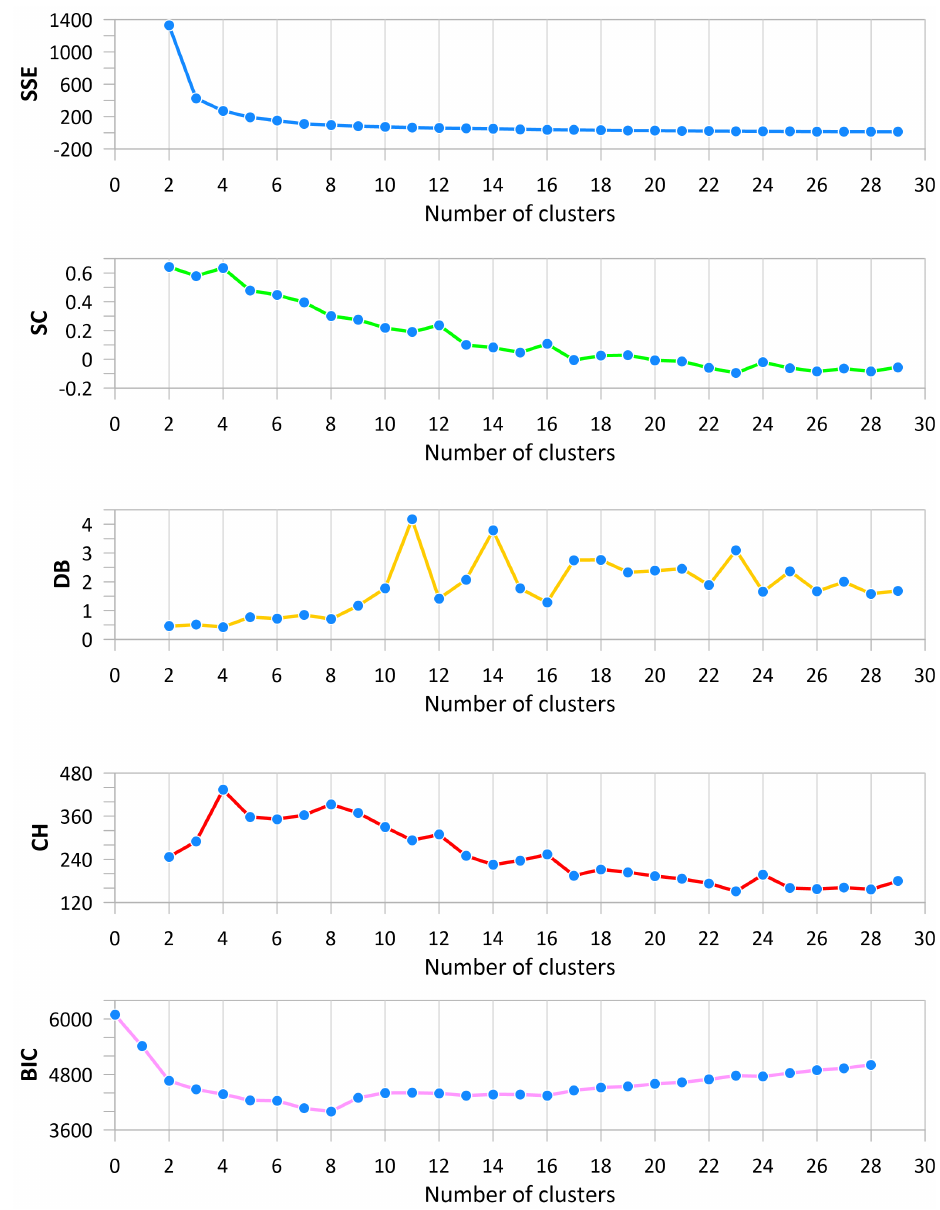
Figure 4. Metrics for cluster number validation for walkaway VSP resolution dataset (inertia analysis— SSE—blue line; silhouette coefficient—SC—green line; Davies–Bouldin index—DB—yellow line; Calinski–Harabasz Index—CH—red line; Bayesian information criterion—BIC—pink